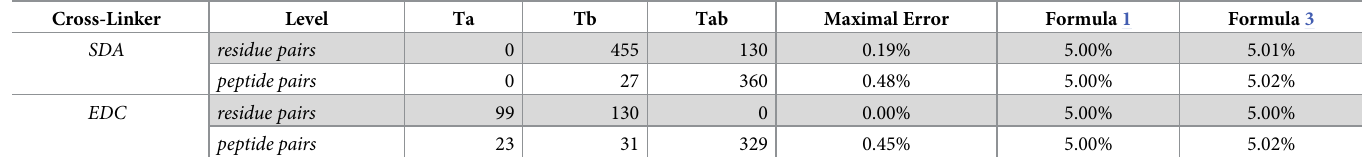
Table 2. Examples of maximal expected error when using the simple formula for HSA, cross-linked with either EDC or SDA.